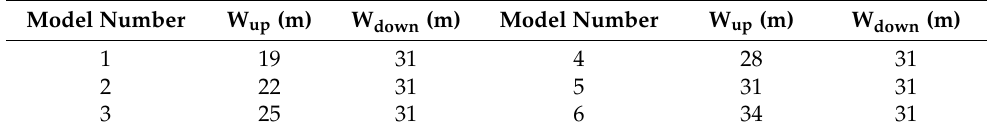
Table 5. Simulated water level for each operating condition (expressed as pressure). Table 4. Values of W up and W down for the models’ working conditions.